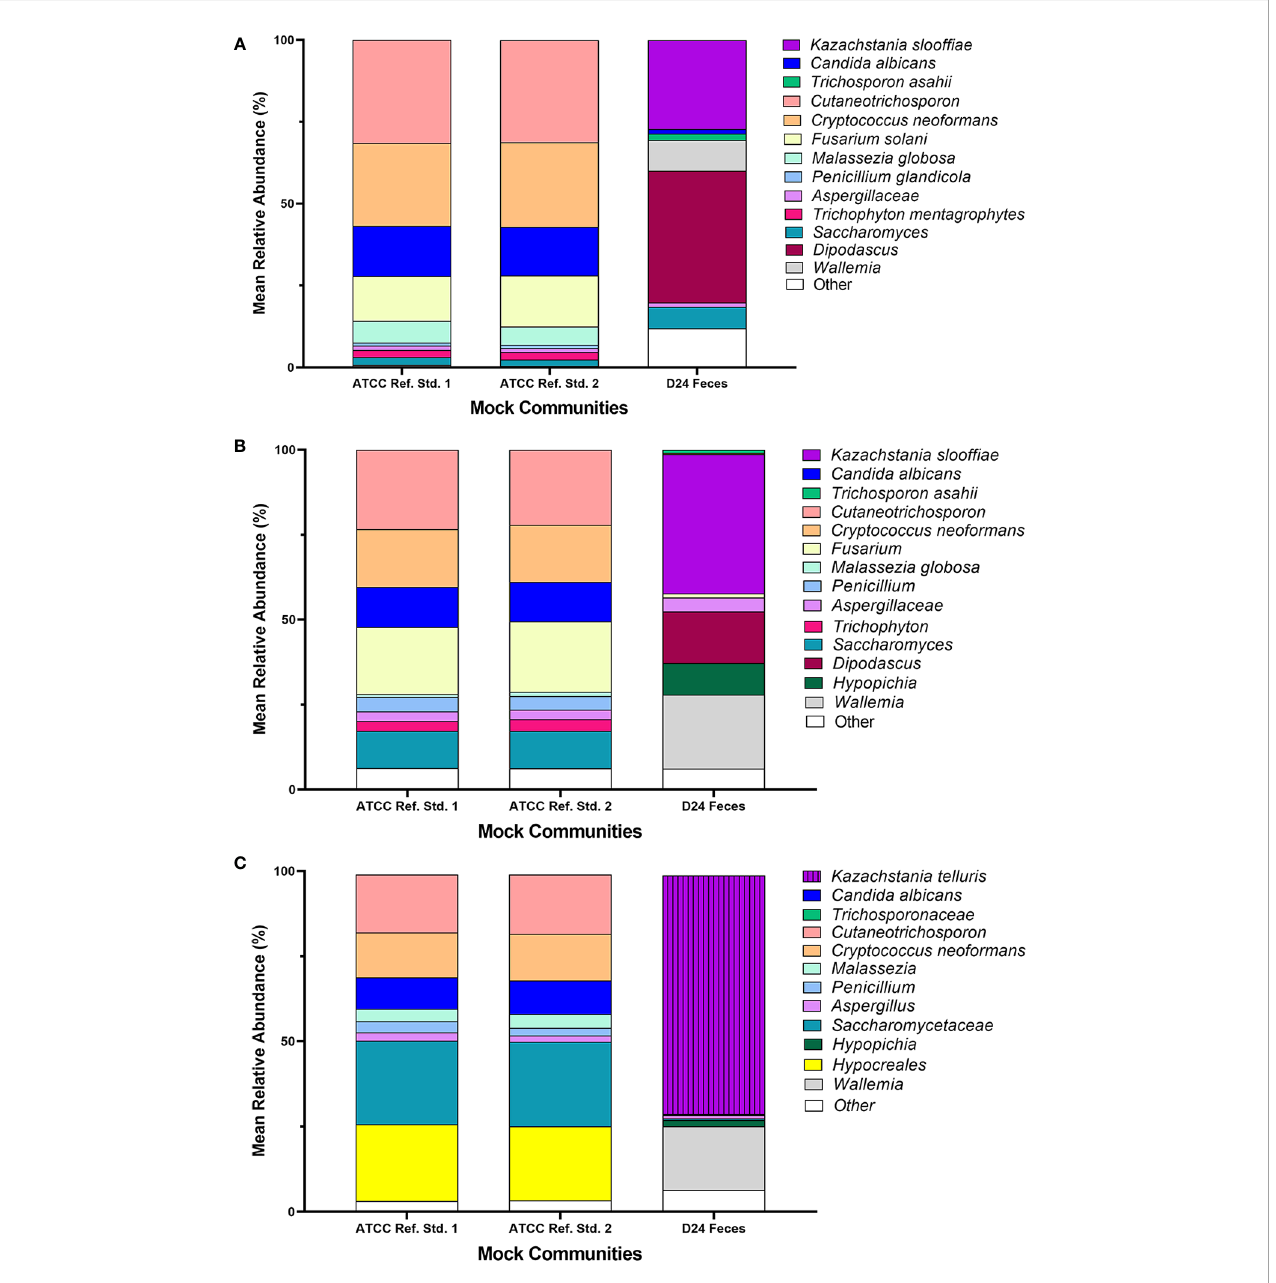
FIGURE 6 (A) ATCC Reference Standard Sequencing Results ITS1. Technical replicates of the ATCC mock fungal community (ATCC Reference Standard 1 and ATCC Reference Standard 2) and DNA extracted from piglet feces (D24 feces) were sequenced on a MiSeq Illumina platform utilizing ITS1 primers. The UNITE database was utilized to identify taxonomy of the population. (B) ATCC Reference Standard Sequencing Results ITS2. Technical replicates of the ATCC mock fungal community (ATCC Reference Standard 1 and ATCC Reference Standard 2) and DNA extracted from piglet feces (D24 feces) were sequenced on a MiSeq Illumina platform utilizing ITS2 primers. The UNITE database was utilized to identify taxonomy of the population. (C) . ATCC Reference Standard Sequencing Results 18S. Technical replicates of the ATCC mock fungal community (ATCC Reference Standard 1 and ATCC Reference Standard 2) and DNA extracted from piglet feces (D24 feces) were sequenced on a MiSeq Illumina platform utilizing 18S primers. The SILVA database was utilized to identify taxonomy of the